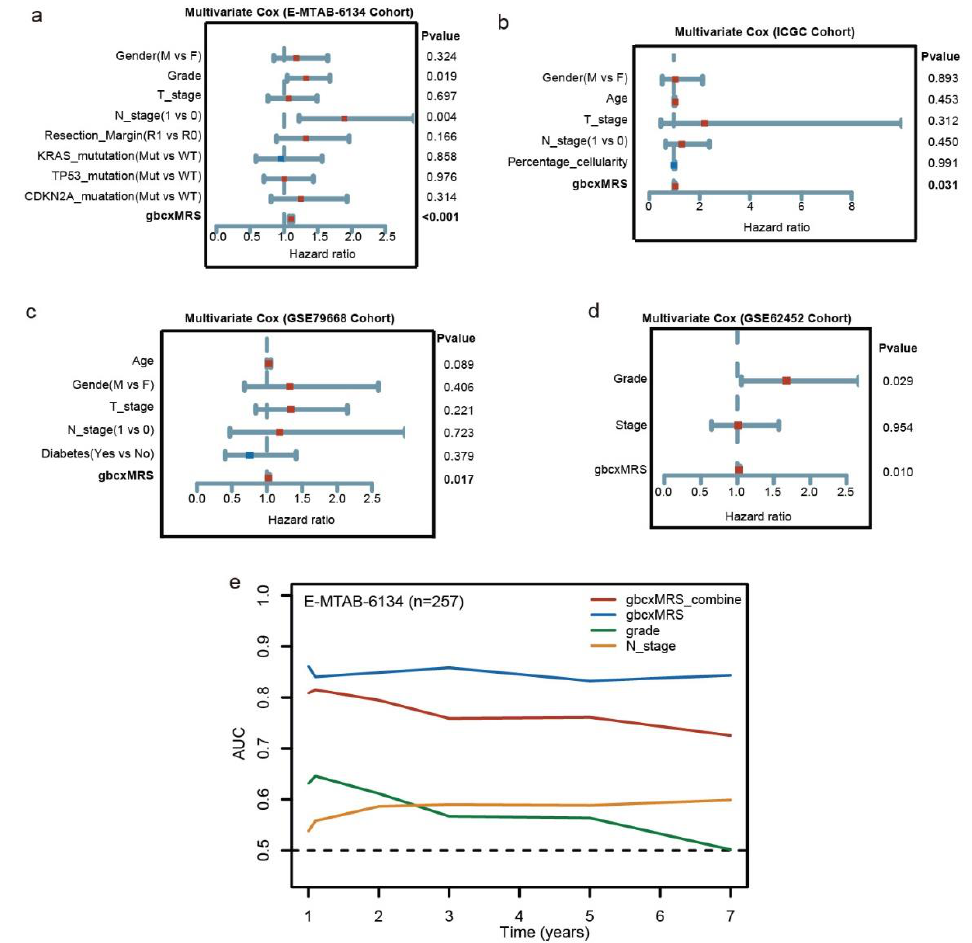
Figure 5. gbcxMRS was an independent and indispensable prognostic factor in PDAC. ( a – d ) gbcxMRS was independent of other clinical variants in the ( a ) E-MTAB-6134 cohort ( n = 257), ( b ) ICGC cohort ( n = 62), ( c ) GSE79668 ( n = 51) and ( d ) GSE62452 ( n = 64). ( e ) AUC of the time-dependent ROC curve of gbcxMRS alone or combined with other clinical indicators in the E-MTAB-6134 cohort. Table 1. Comparison of clinical features between the high and low gbcxMRS groups in the E-MTAB- 6134 cohort.